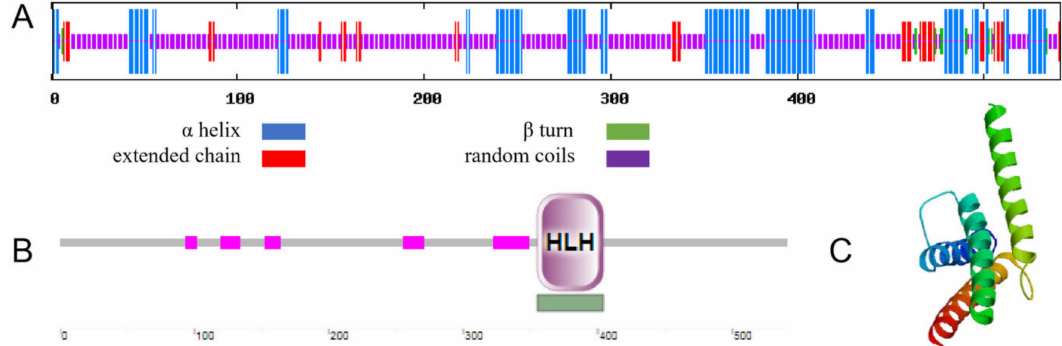
Figure 2. Structure and domain prediction of MbICE1. ( A ) Secondary structure of MbICE1. ( B ) Func- tional domain of MbICE1. ( C ) Tertiary structure of MbICE1.